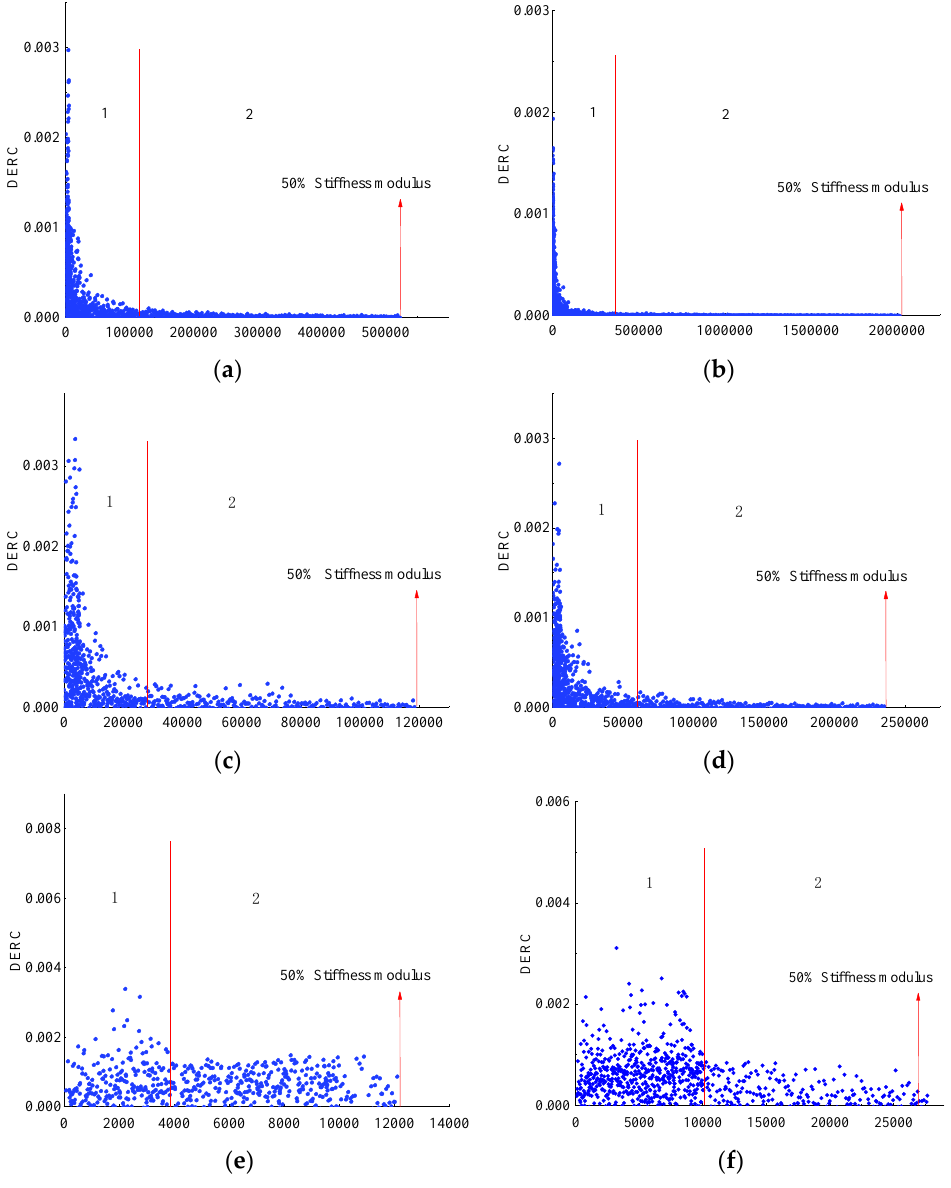
Figure 11. Change rate of dissipated energy: ( a ) SUP-20 (450 με) , ( b ) SUP-20 with BF (450 με) , ( c ) SUP-20 (650 με) , ( d ) SUP-20 with BF (650 με) , ( e ) SUP-20 (850 με) and ( f ) SUP-20 with BF (850 με) .